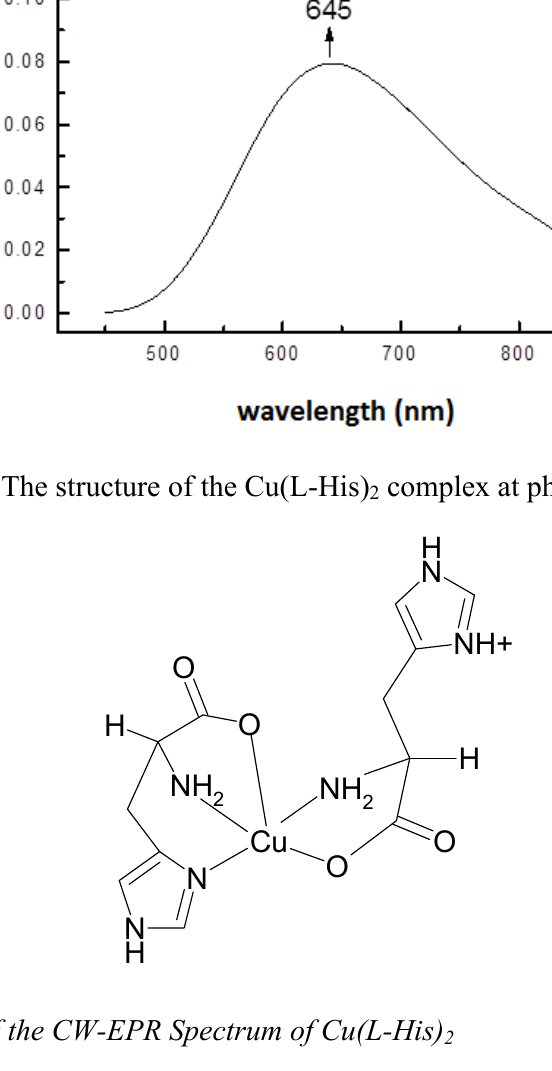
Figure 4. Absorption spectrum of (1:2) copper-histidine complex in PBS at room temperature.